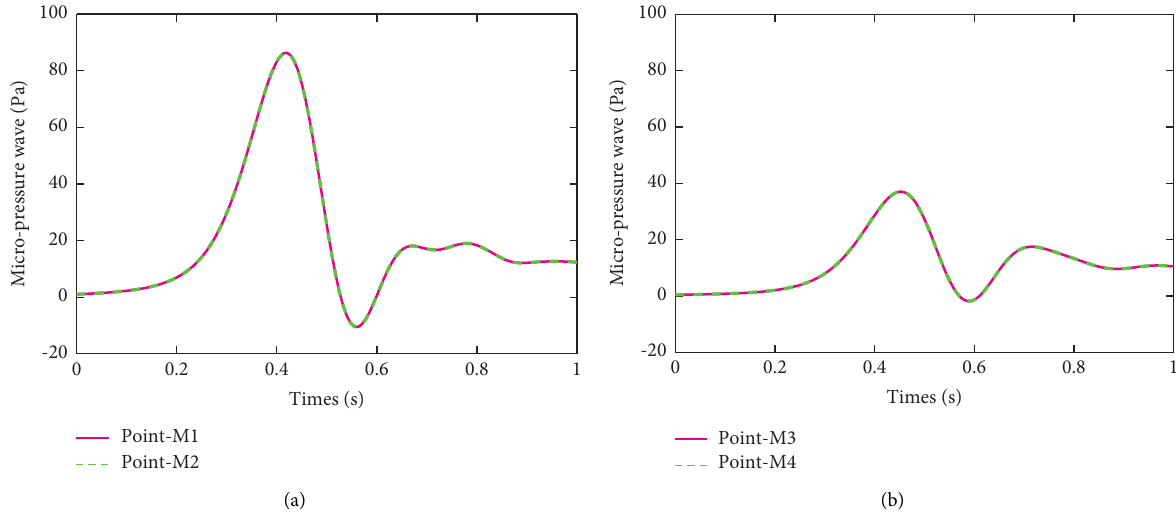
Figure 7: Comparison of micropressure wave in the same plane. (a) 20 m outside the tunnel exit. (b) 50 m outside the tunnel exit. Table 3: Te maximum pressure gradient and micro-pressure wave. Te position of the linings Without